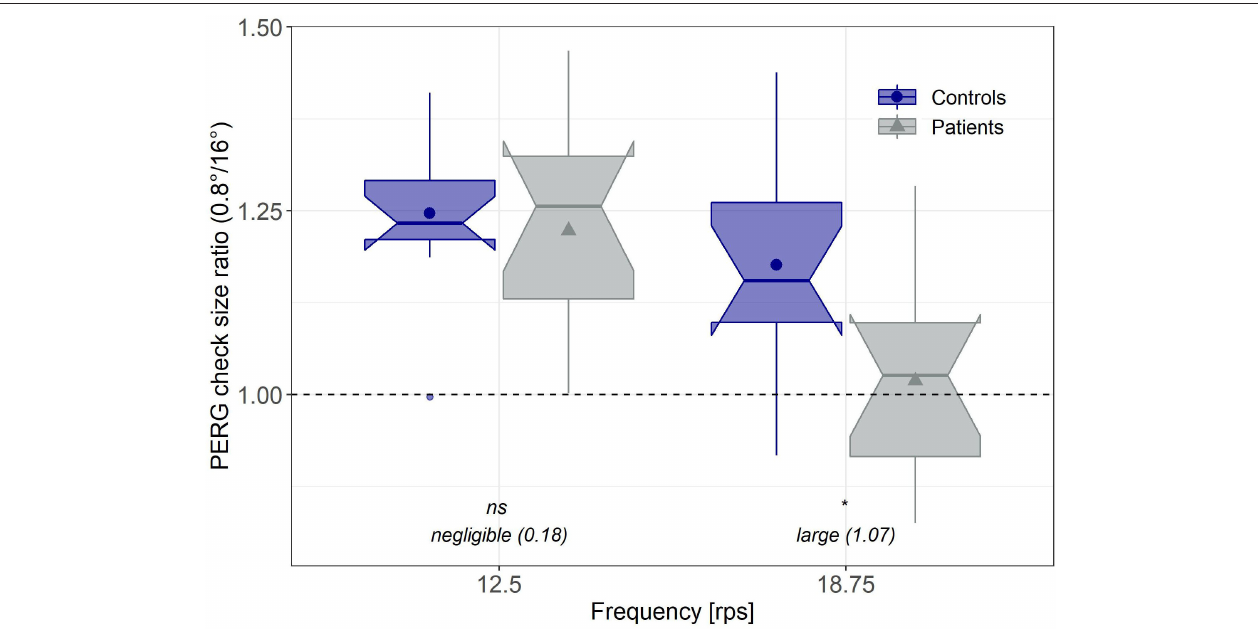
FIGURE 3 | Normalized PERG amplitudes. Individual PERG ratios (0.8 ◦ /16 ◦ ) corresponding to the “PERG ratio protocol” for early glaucoma (17) for both groups and frequencies. Significance levels were Bonferroni-Holm corrected. Effect sizes were estimated based on Hedge’s corrected Cohen’s d. *significant; ns, not